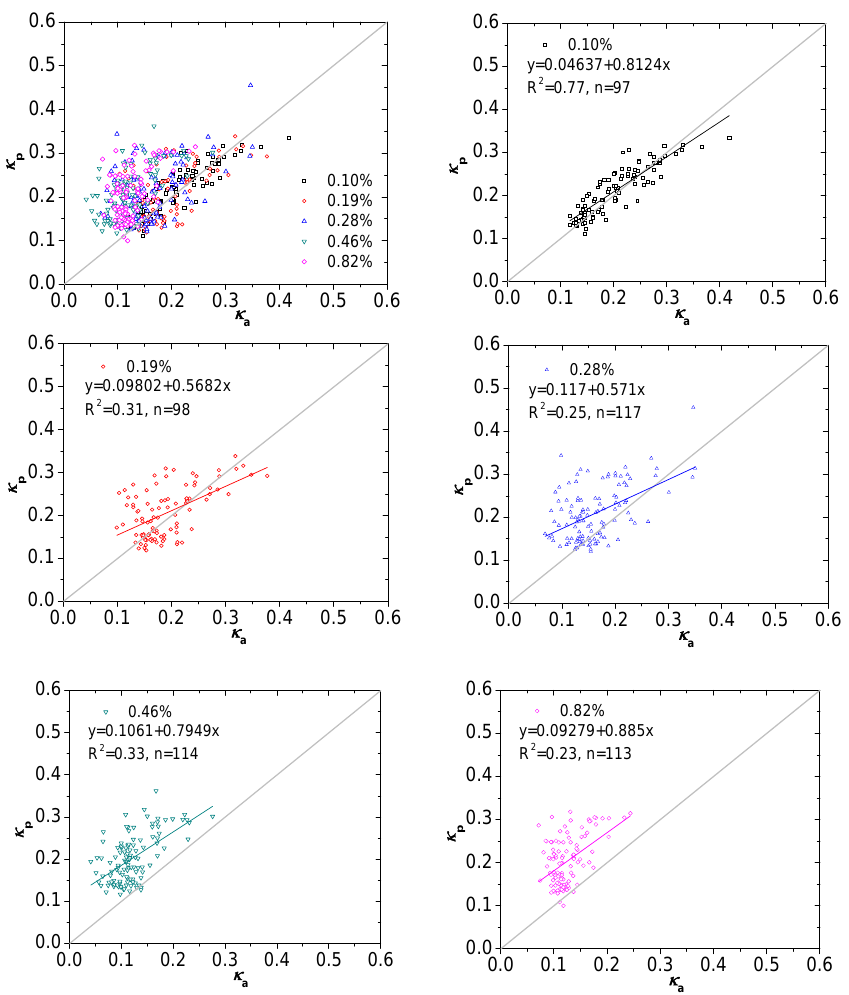
Fig. 14. Effective hygroscopicity parameters predicted from the organic and inorganic mass fractions determined by integral AMS measurements ( κ p ) plotted against the values obtained from CCN measurements ( κ a ) for all investigated supersaturations (a) and for individual supersaturations (b-f, S = 0.10-0.82%). The colored lines are standard linear least-squares fits, and the diagonal grey lines indicate 1:1 ratio.